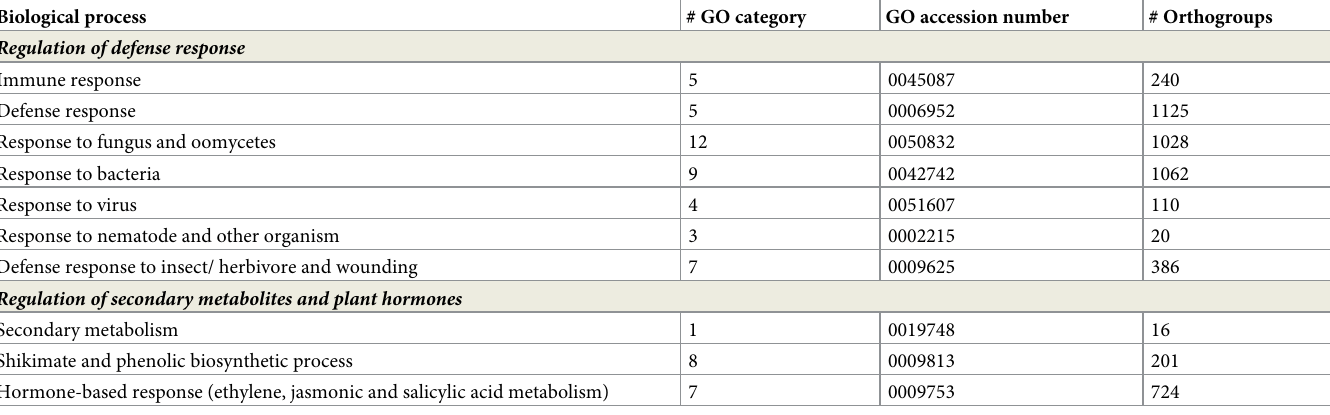
Table 1. Functional categories from 30 Oenothera taxa of orthogroups related to defense and secondary metabolism with gene ontology (GO) annotations. For each GO biological process, we provide the sum of annotations related to gene ontology categories, a representative accession number of each category and the number of orthogroups associated with annotations of specific